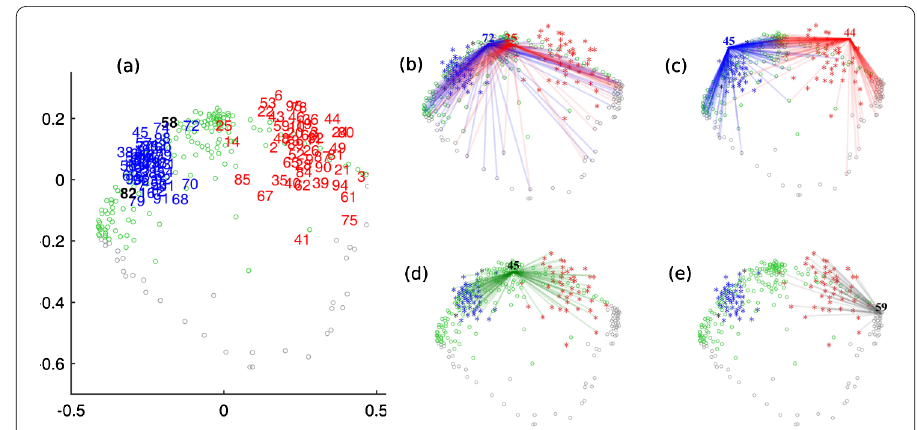
Figure 4 BiFold of voting records: US Senate, 112th Congress, Session 1. (a) BiFold layout of Senate voting data. Senators are numerically labeled (based on alphabetical order), with Republicans in red, Democrats in blue, and Independents in black. Votes that passed are colored green, while those that did not pass are gray. Observe that the two “Independents,” Senators Lieberman (58) and Sanders (82) align with the broad democratic party cluster, but both near its fringe. Republican Senators Snowe (85), Brown (14), and Collins (25) appear (by the BiFold plot) to have the most liberal voting record of their party. (b-d) Further aspects of the BiFold Senate layout. (b) “Nearby” senators Collins (R-25) and Nelson (D-72), with lines connecting each senator position to their respective “yes” votes. Both show strong bipartisanship in